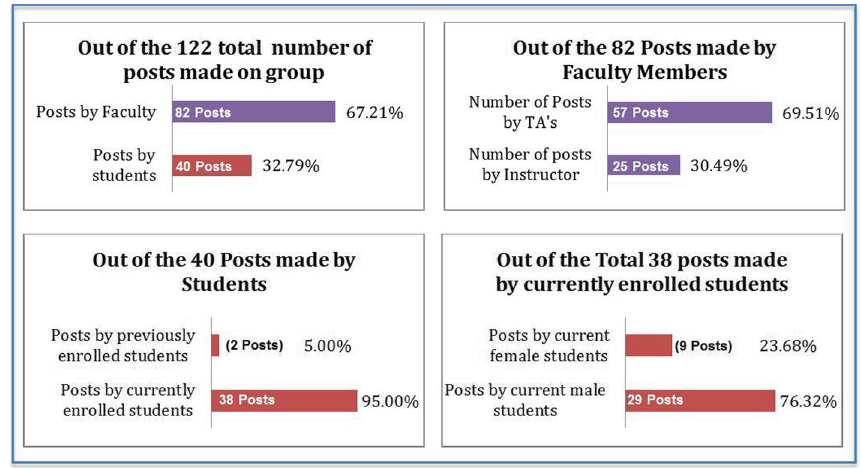
Fig. 3 Bar charts presenting numbers and percentages of the posts made on the group in regards of “Who” is posting